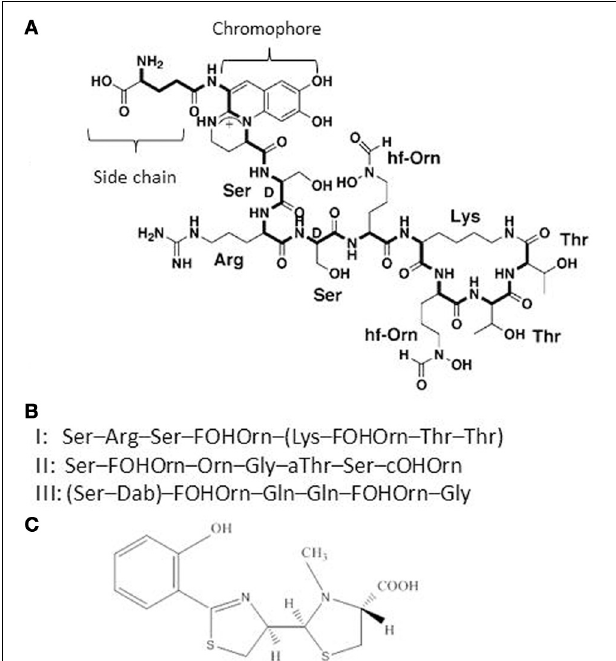
FIGURE 1 | (A) Structure of the P. aeruginosa type I pyoverdine [taken from Ravel and Cornelis (2003)]. (B) Sequence of the peptide chains from P. aeruginosa type I, II, and III pyoverdines. (C) Structure of the second P. aeruginosa siderophore pyochelin.